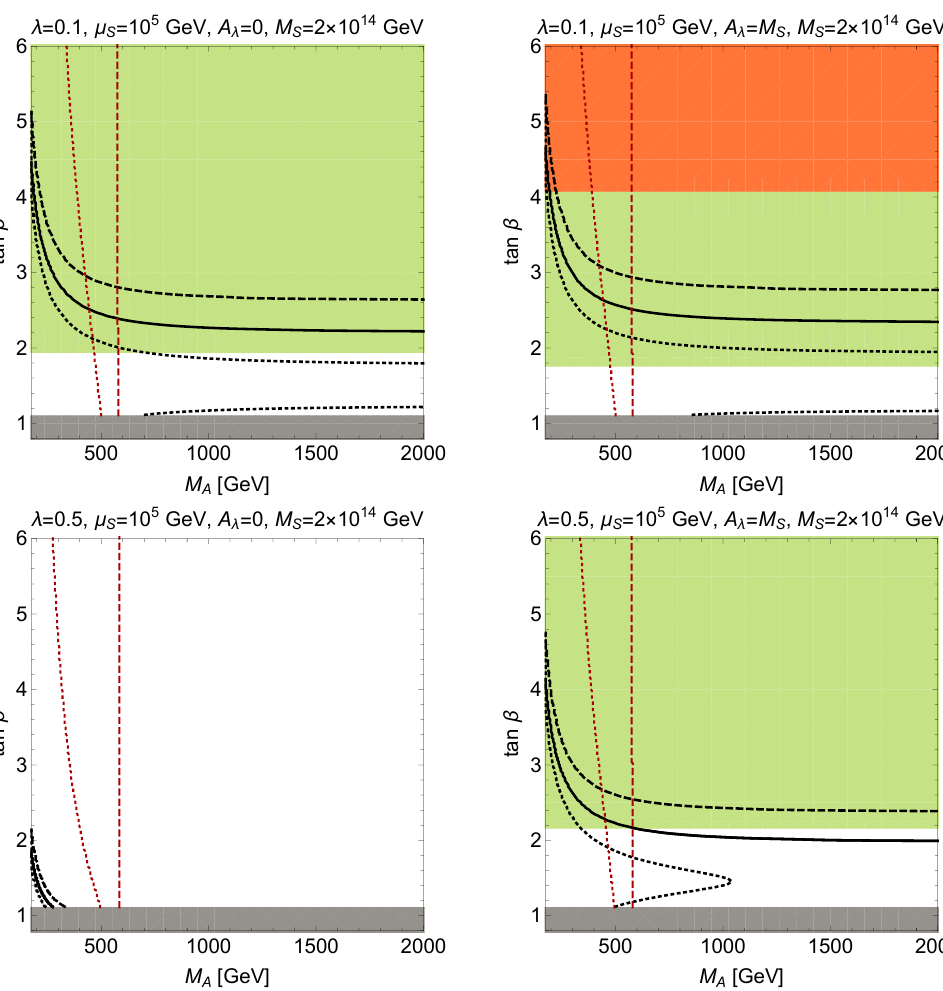
Figure 4 . Contours of M h = 125 GeV (solid black), 122 GeV (dotted black) and 128 GeV (dashed black) on tan (cid:12) - M A plane for M t = 173 : 1 GeV, (cid:22) = 1 TeV, (cid:22) S = 10 5 GeV, M S = 2 (cid:2) 10 14 GeV, and for di(cid:11)erent values of (cid:21) and A (cid:21) . The grey region is disfavoured by perturbativity while the unshaded, green and orange regions correspond to absolute stability, metastability and instability of electroweak vacuum, respectively. The region on the left side of the dashed and dotted red contours & 580 GeV and j cos( (cid:12) (cid:0) (cid:11) ) j . 0 : 055, is disfavoured by the constraint M H (cid:6)